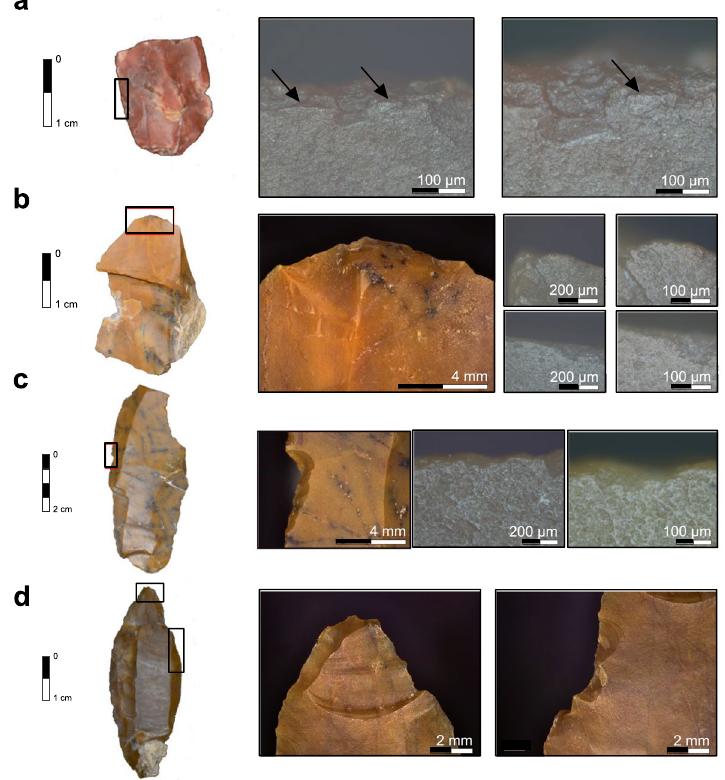
Figure 7. Use-wear traces found on lithic artifacts from Române ș ti- Dumbrăvi ț a I, GH3. ( a ) Localized microfracturing and compact polish of the lateral edge characteristic of hard animal material scraping (on the right side, 10 × and 20 × objective); ( b ) Abrasive polish and rounding of the distal end of the ventral surface characteristic for hide-scraping (on the right side, 10 × and 20 × objective); ( c ) Striated and extensive polish on the ventral surface of a steeply notched lateral edge characteristic of wood scraping (on the right side, 10 × and 20 × objective); ( d ) Macrofracture traces found on a lithic artifact. ( left ) spin-off fracture initiated on the dorsal distal tip on the lateral side with feather termination. ( right ) lateral ventral notching and edge